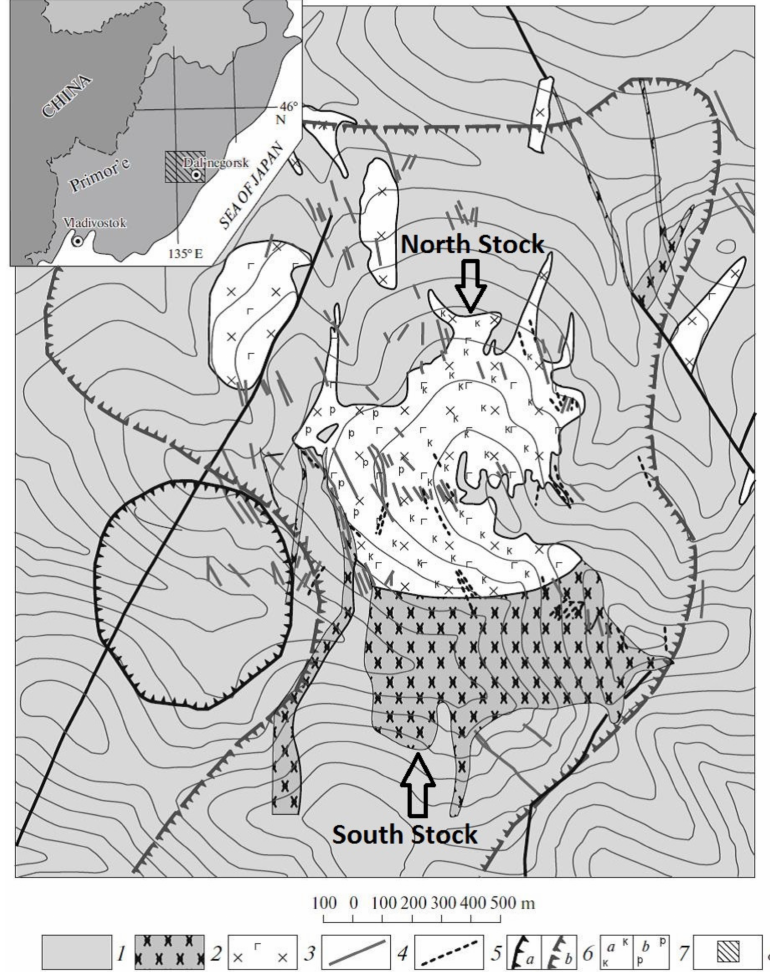
Figure 10. A geologic scheme of the Lazurnoe deposit (after [31] and references therein). (1) Early Cretaceous sedimentary rocks; (2) adakitic monzodiorite and monzo-gabbro-diorite (2nd phase); (3) gabbro–monzodiorite and diorite (1st phase); (4) dykes of quartz monzodiorite; (5) quartz–sulfide veins and porphyry sulfide ores; (6) projections to the surface of: (a) the hidden porphyritic massif, (b) the copper–porphyry mineralization; (7) hydrothermal alterations: (a) potassium-feldspar, (b) propylitic; (8) the study area.